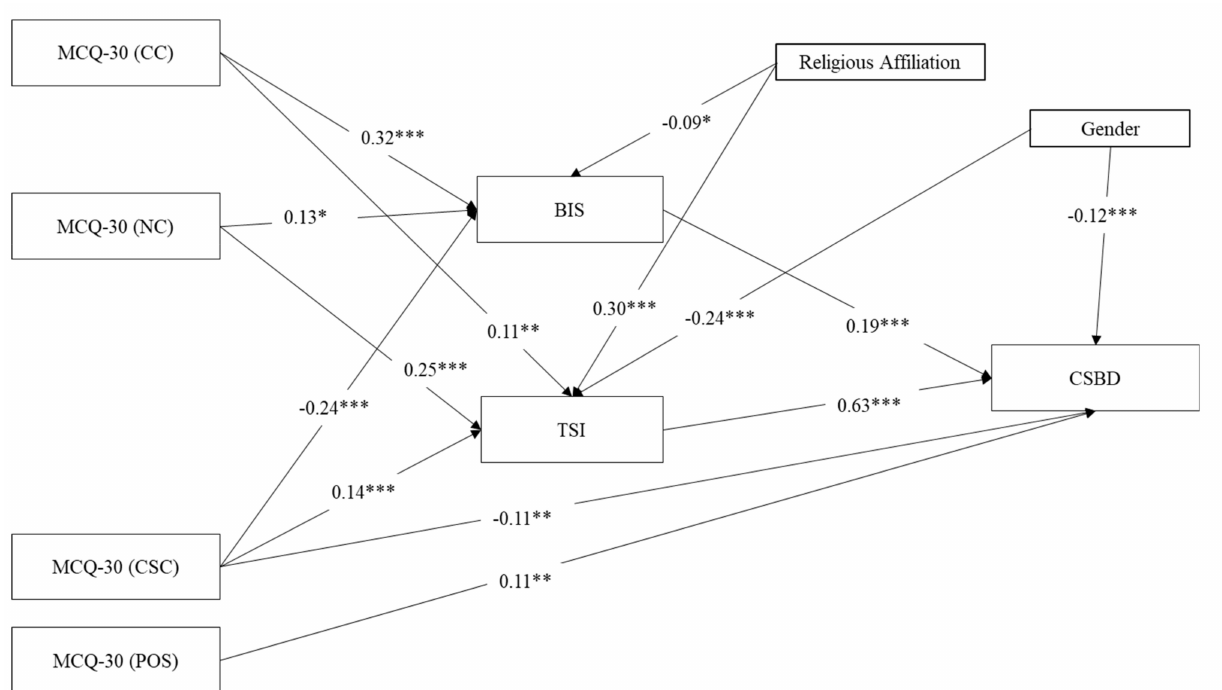
Figure 3. Results of the path analytical model with CSBD as outcome variable. Notes: * p < 0.05, ** p < 0.001, *** p < 0.001; n = 453; Coefficients are standardized estimates; Religious Affiliation = (1 = Low, 2 = High); Gender: 1 = M, 2 = F; MCQ-30 (POS) = Metacognitions Questionnaire-30 (Positive Beliefs about Worry); MCQ-30 (CC) = Metacognitions Questionnaire-30 (Cognitive Confidence); MCQ-30 (NC) = Metacognitions Questionnaire-30 (Beliefs about the Need to Control Thoughts); MCQ-30 (CSC) = Metacognitions Questionnaire-30 (Cognitive Self-Consciousness); BIS = Barret Impulsivity Scale; TSI = Thought Suppression Inventory; CSBD = Compulsive Sexual Behavior